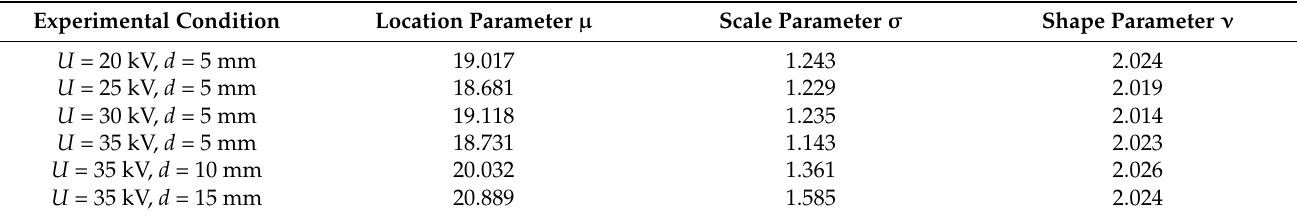
Table 5. Fitted distribution parameter of t r